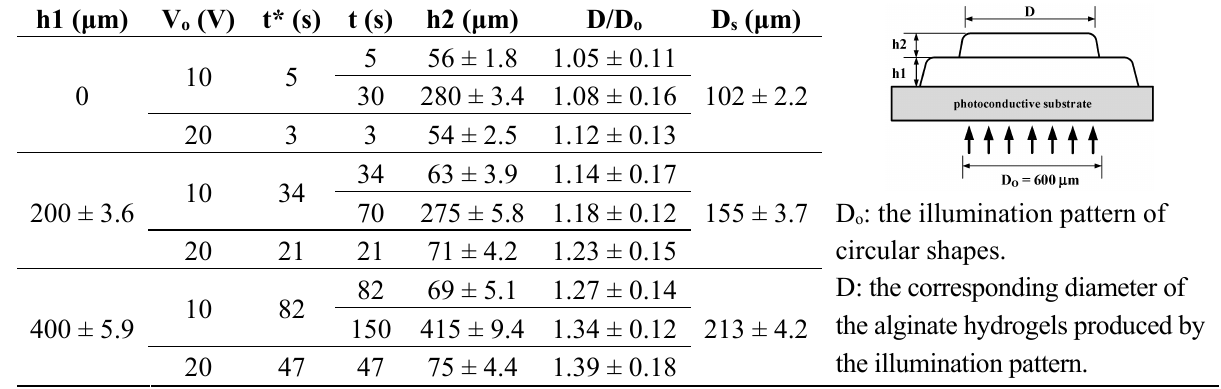
Table 1. The dimensional characterization of the second layer of the alginate hydrogel produced at different thicknesses (h1) of the preformed alginate hydrogel beneath. t*: the least illumination time required for alginate hydrogel formation; t: illumination time; D/D o : dimensional resolution; h2: thickness of the second layer of alginate hydrogels; V o : applied voltages; D s : the smallest feature size.